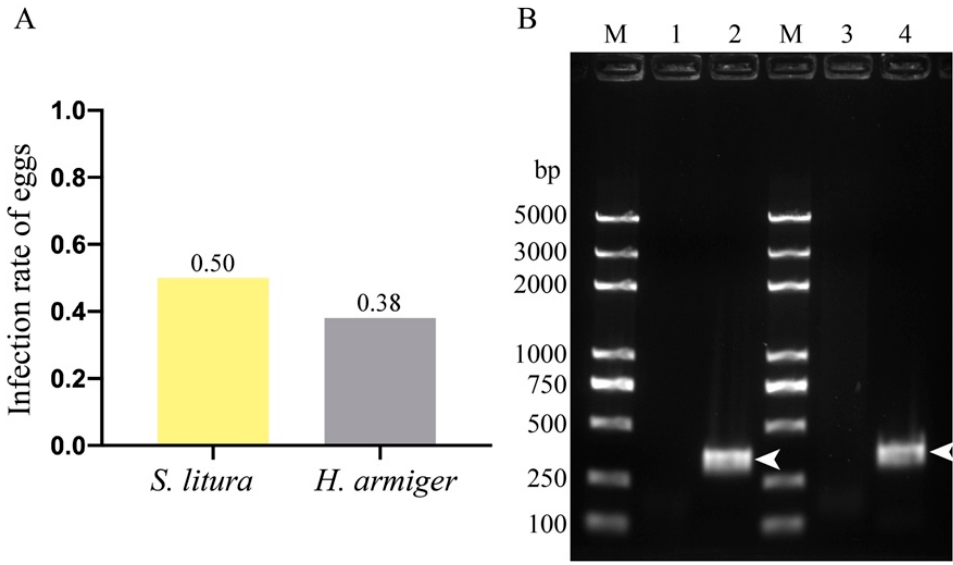
Figure 5. Determination of NbCQ1 infection in the eggs of S. litura and H. armigera . ( A ) Infection rates of NbCQ1 in the eggs of S. litura and H. armigera were counted by light-microscopic observation. ( B ) Infections of NbCQ1 in the eggs of S. litura and H. armigera were detected using PCR with primers targeting NbCQ1 LSU. PCR products were verified using the agarose gel electrophoresis. (Lane M) Trans2k Plus DNA Marker; (Lane 1, 3) PCR amplification of normal S. litura and H. armigera egg gDNA; (Lane 2, 4) PCR amplification of infected S. litura and H. armigera egg gDNA; Arrowheads showed the PCR products of NbCQ1 LSU.